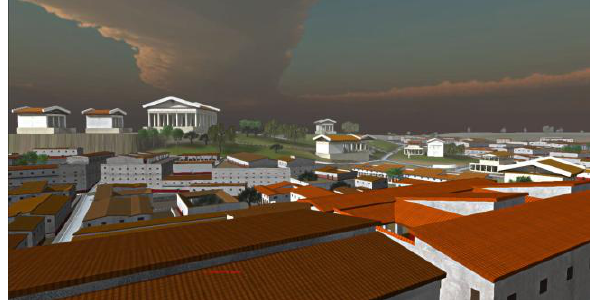
Figure 5. Complete model of the Republican Roman Forum in